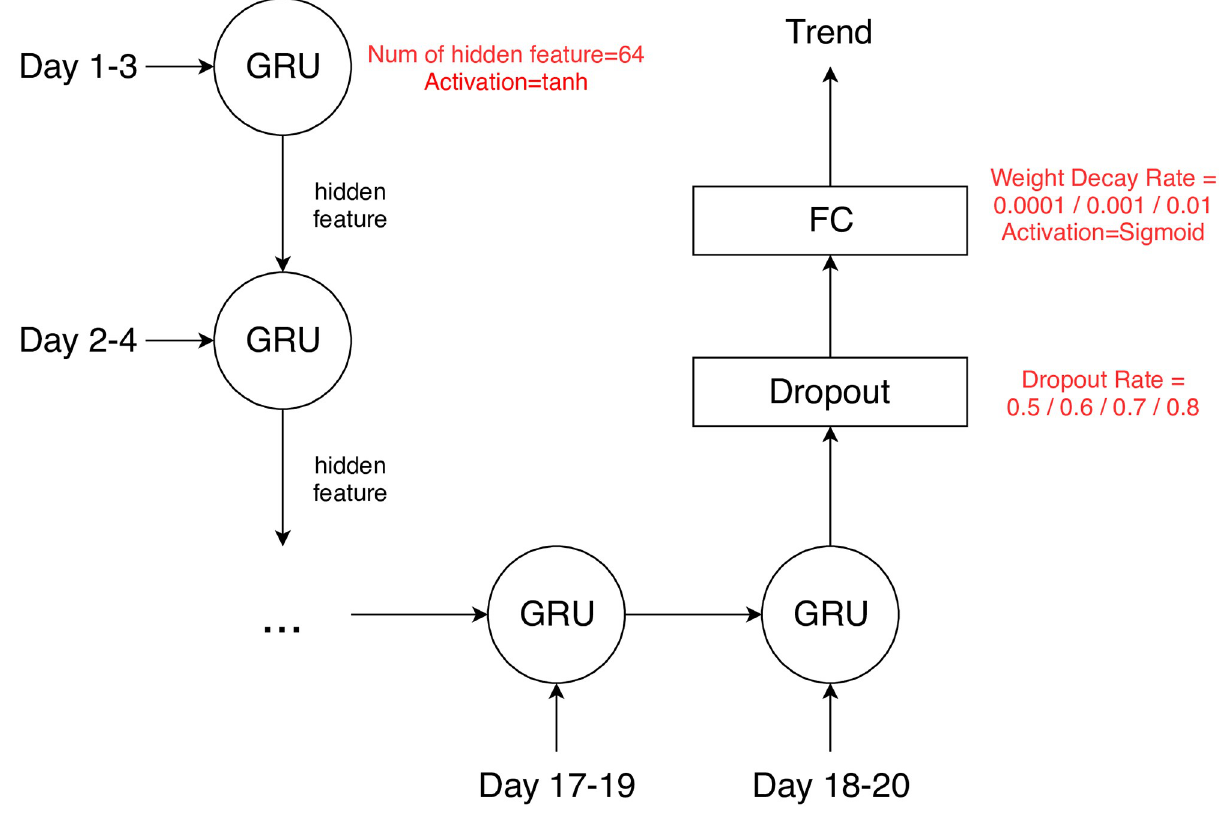
Fig 6. RNN with GRU gating